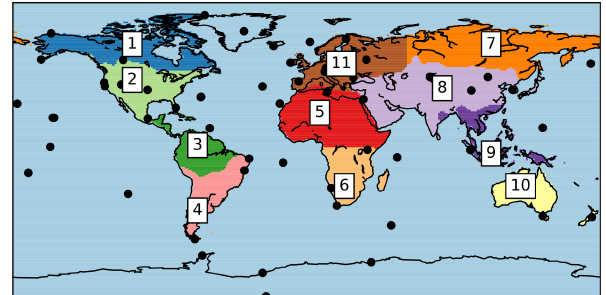
Figure 1. Locations of Global Atmosphere Watch stations, denoted by black dots, and different TransCom regions (different numbers denote the different TransCom regions in this study), denoted by different